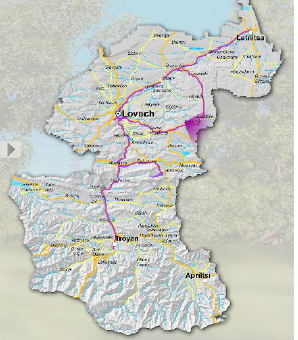
Figure 4. Route with museums in the region